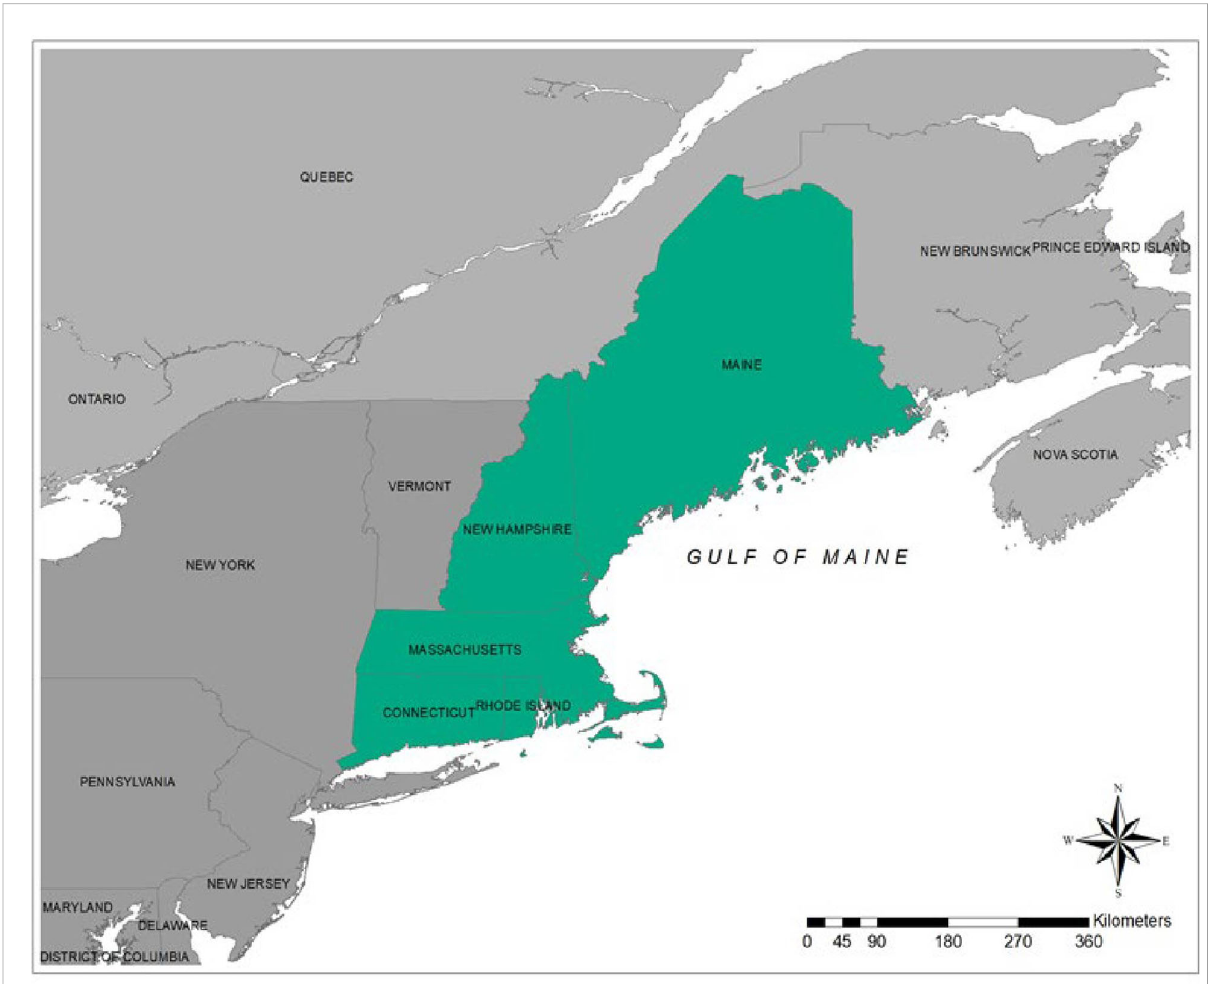
Figure B3; Nelson, 2023). Categorical responses (i.e., somewhat, very, none) for the Likert-scale questions were changed to numerical responses (0-1) to fi rst calculate an individual ’ s risk ( r ) as the Euclidean distance from the origin with axes de fi ned by exposure ( e ) and sensitivity ( s ) (Samhouri and Levin, 2012; Eq. 1). Vulnerability ( v ) is also calculated using the Euclidean distance method (Samhouri and Levin, 2012) with risk and expressed by distance from the origin (Eq. 2). The higher